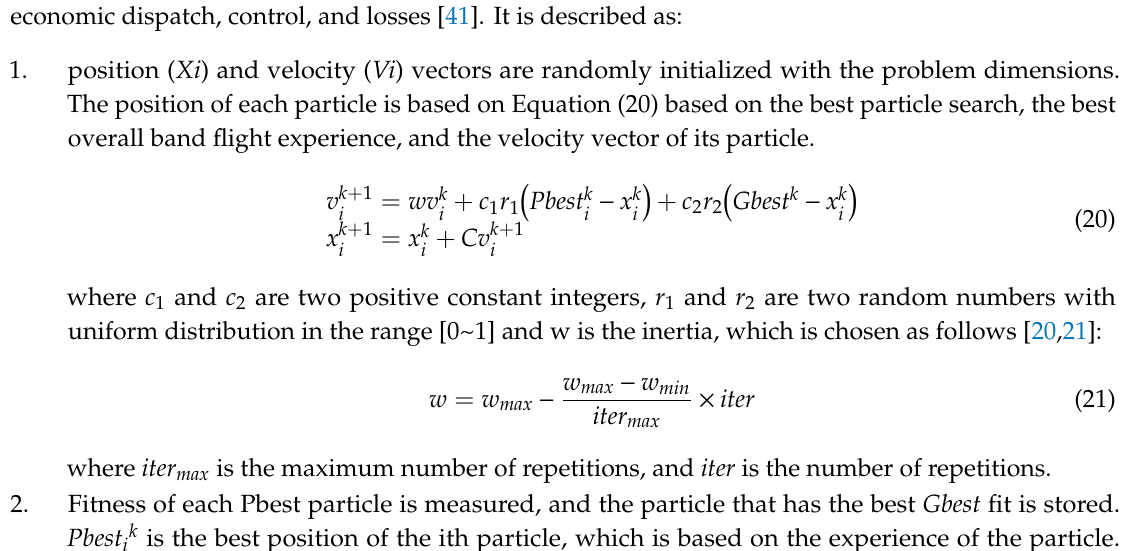
Figure 12. The shaved peak by UC bank to achieve the optimal power profile for the STS crane in kW.